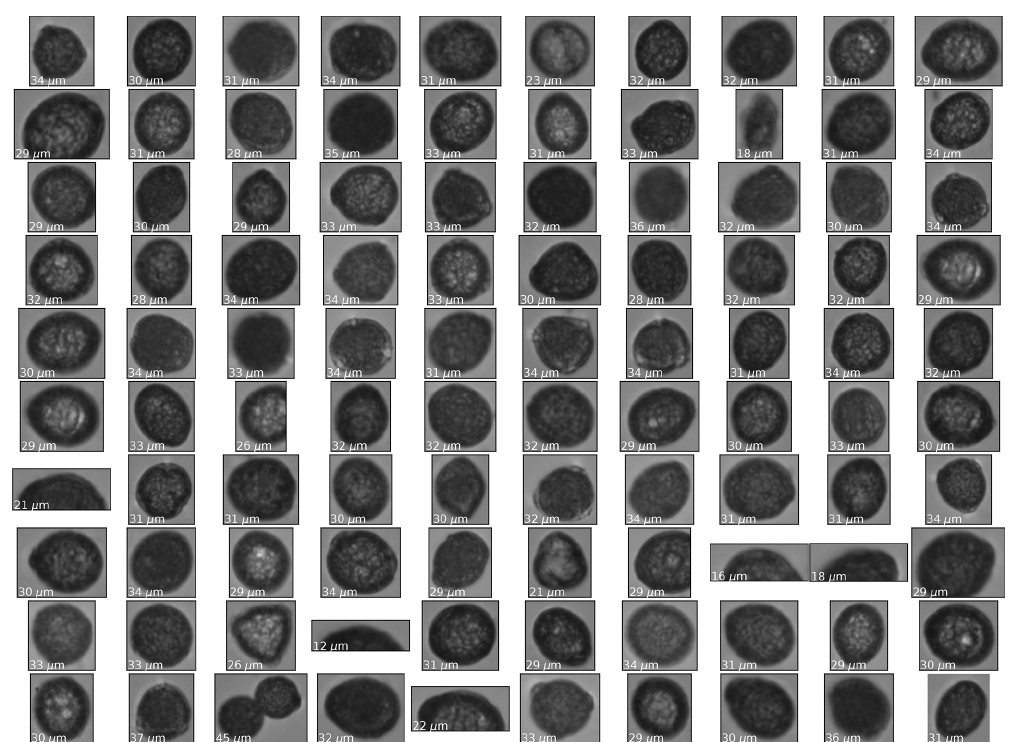
Figure C5. Quercus robur